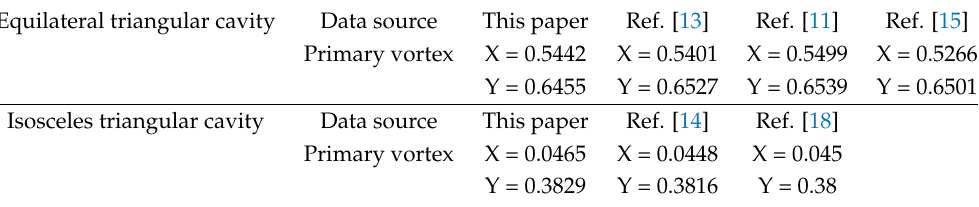
Table 1. The position of primary vortices of the lid-driven equilateral and right-angled isosceles triangular cavity at Re = 500 and Re = 100,